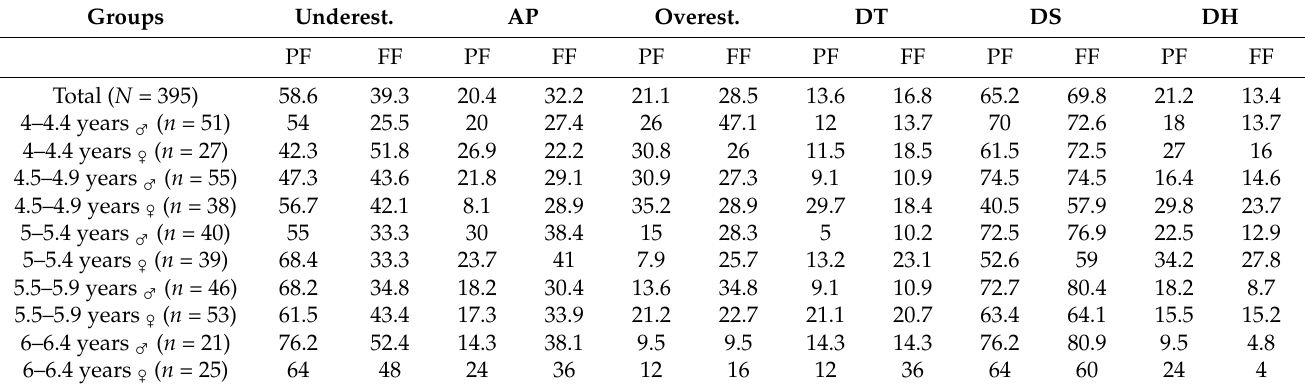
Table 1. Frequencies (%) of body-size perception and body ideal according to gender and age.